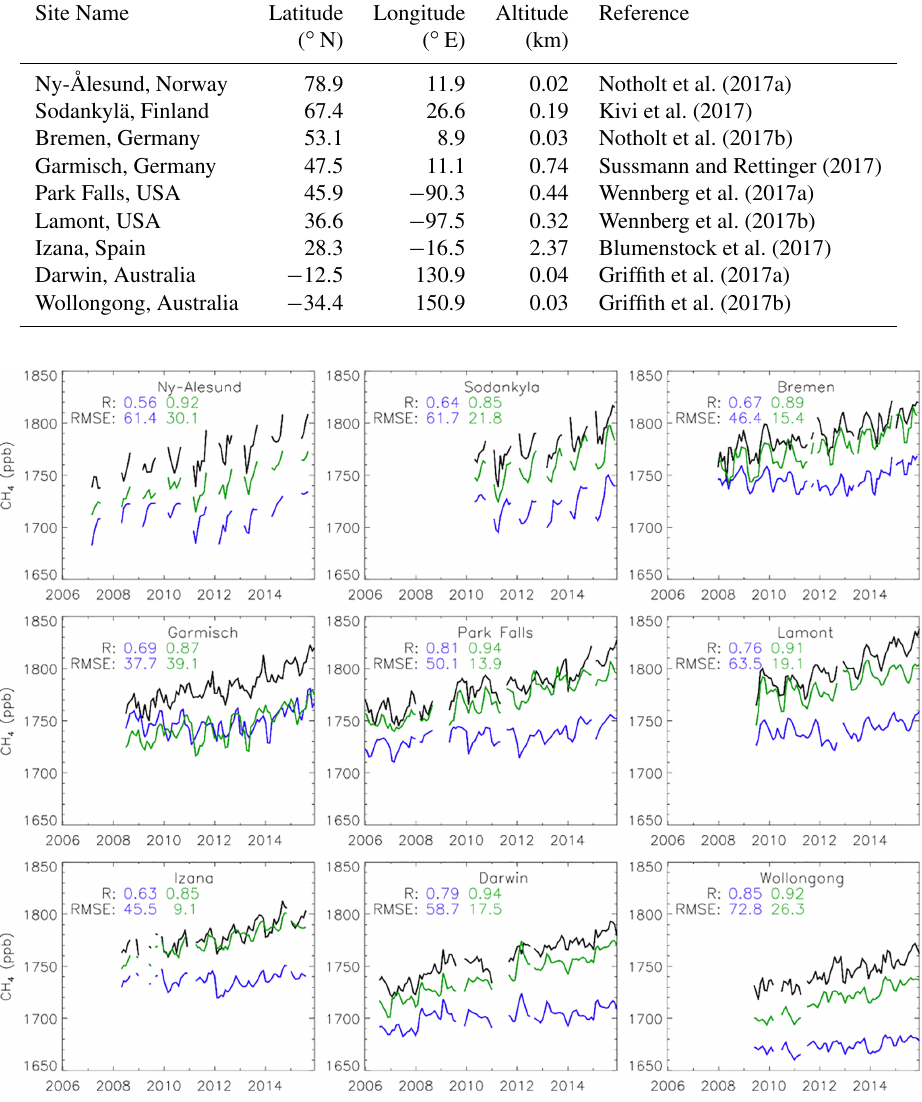
Figure 4. Observed monthly mean XCH 4 volume mixing ratio (ppb) (black line) at nine TCCON sites. Also shown are results from TOMCAT simulations with prior (blue) and posterior (green) emissions estimates, both with TCCON averaging kernels applied. Correlation coefficients and RMSE of the model simulations compared with TCCON are shown for each